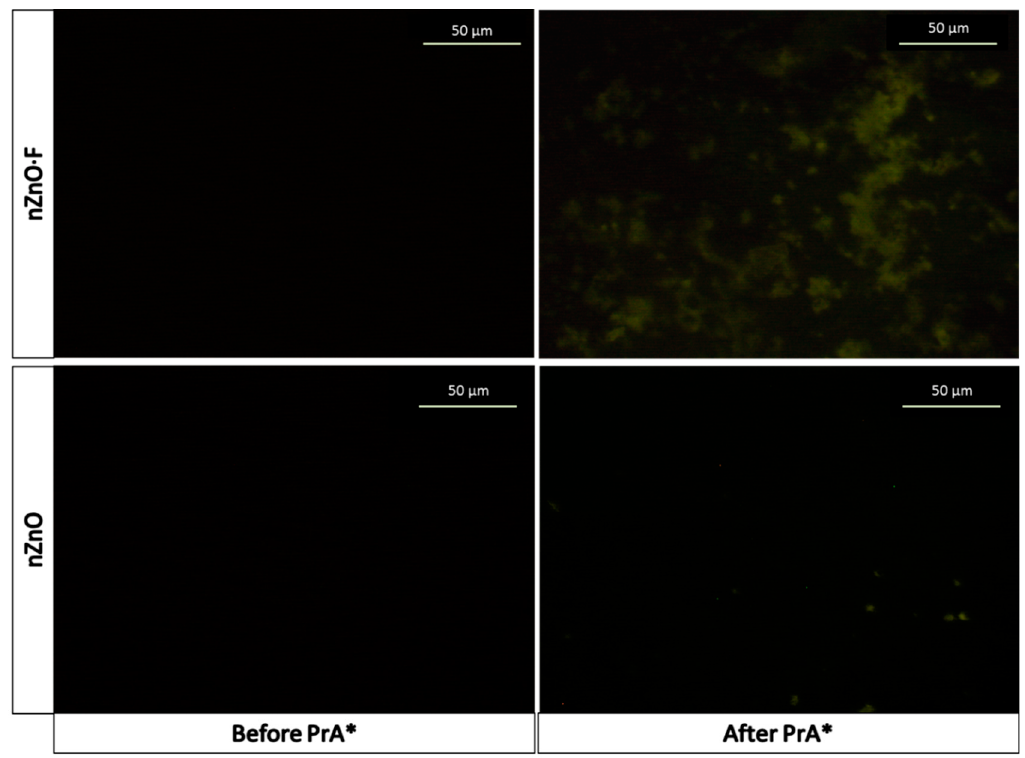
Figure 4. Fluorescence microscopy imaging of nZnO · F (upper line) and nZnO (lower line) before and after functionalization with PrA*.